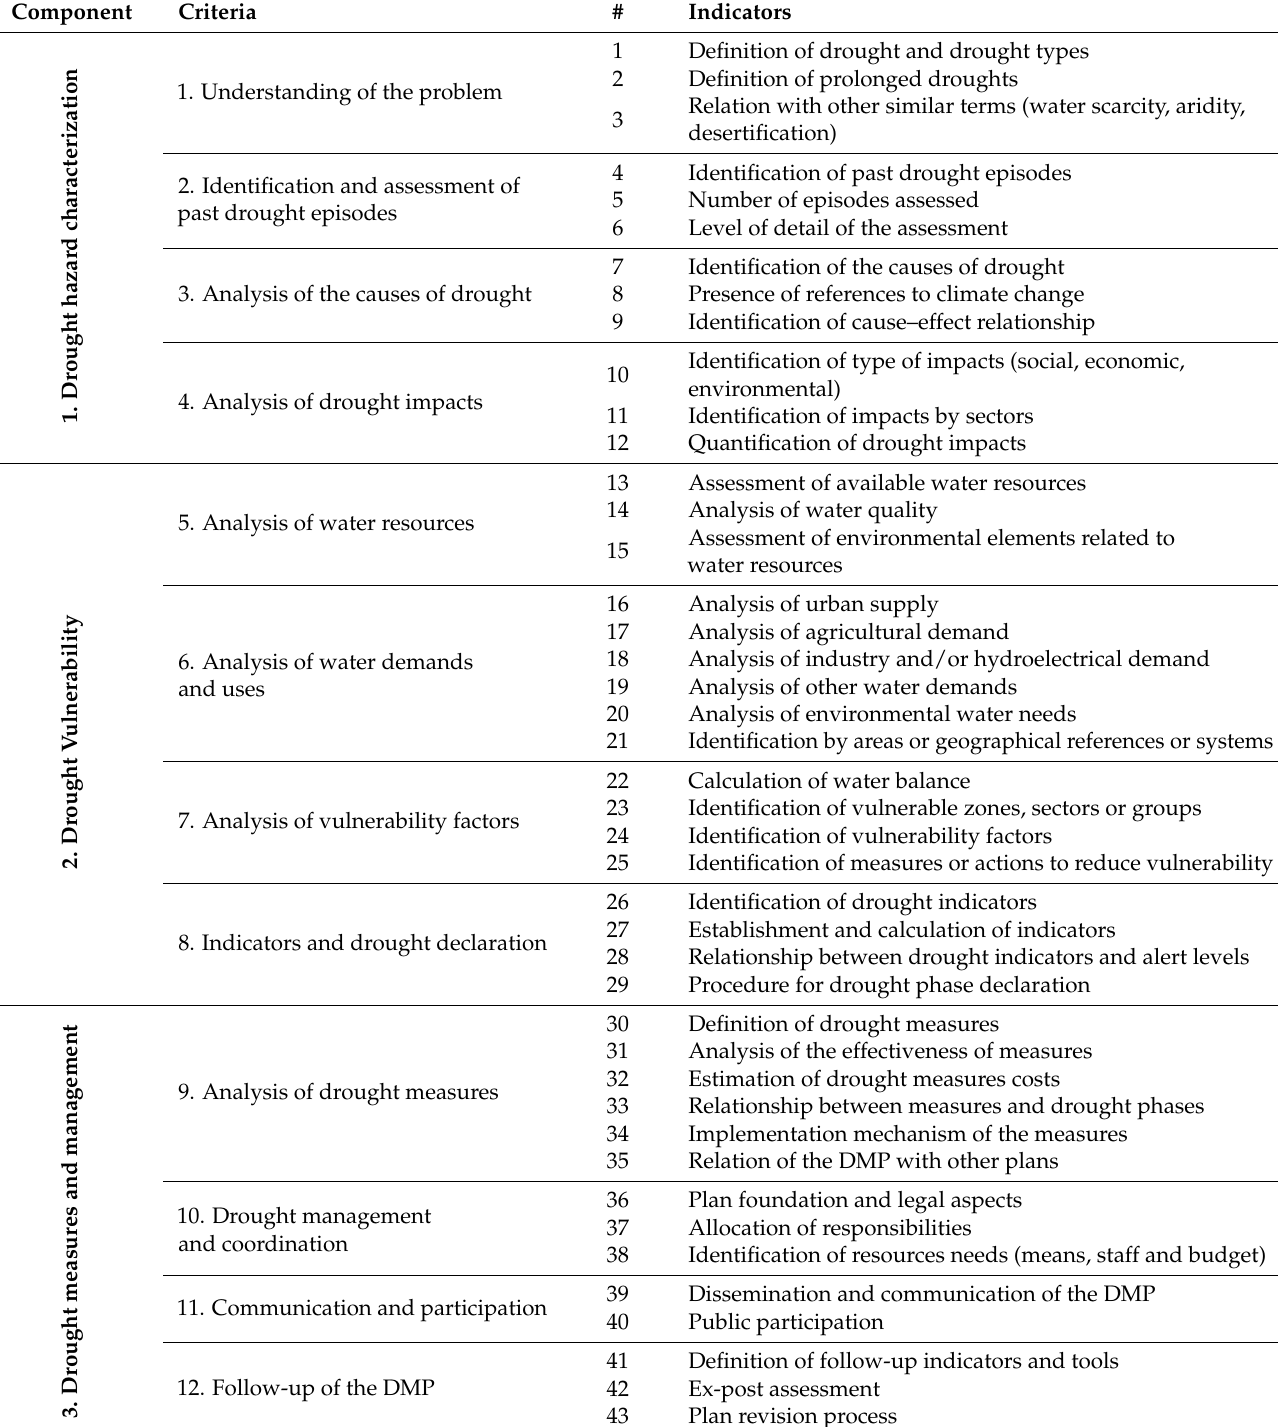
Table 1. Assessment